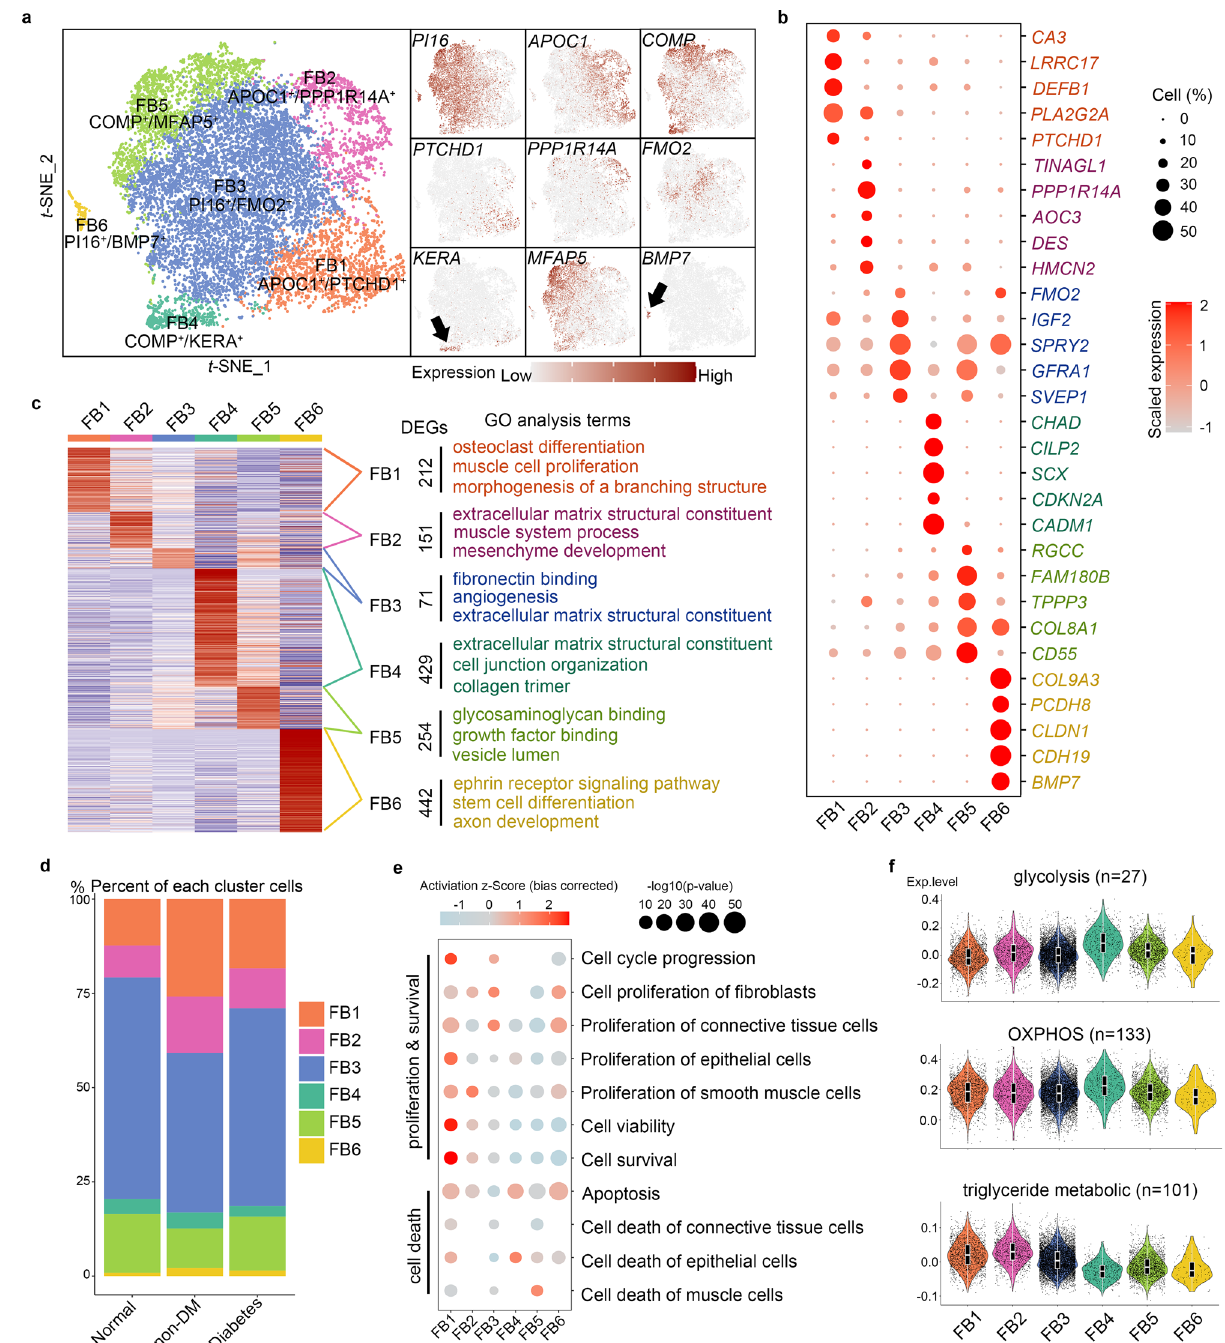
Fig. 2 | Transcription characteristics and heterogeneity among the six FB subclusters.a tSNEplotsof the six fi broblast(FB)subclusters. Cells arecoloured according to their types (left panel) or expression level of the markergene (right panel). b Bubble diagram of the top fi ve DEGs in each FB subcluster. A gradient of grey to red indicates low to high expression levels. The size of bubbles indi- cates the percentage of cells positive for DEGs in each subcluster. c Heatmap showing the DEGs in each FB subcluster (left panel) based on normal samples. The GO terms (biological process) associated with their DEGs are listed in the right panel. The count of DEGs for each FB subcluster are listed in the middle